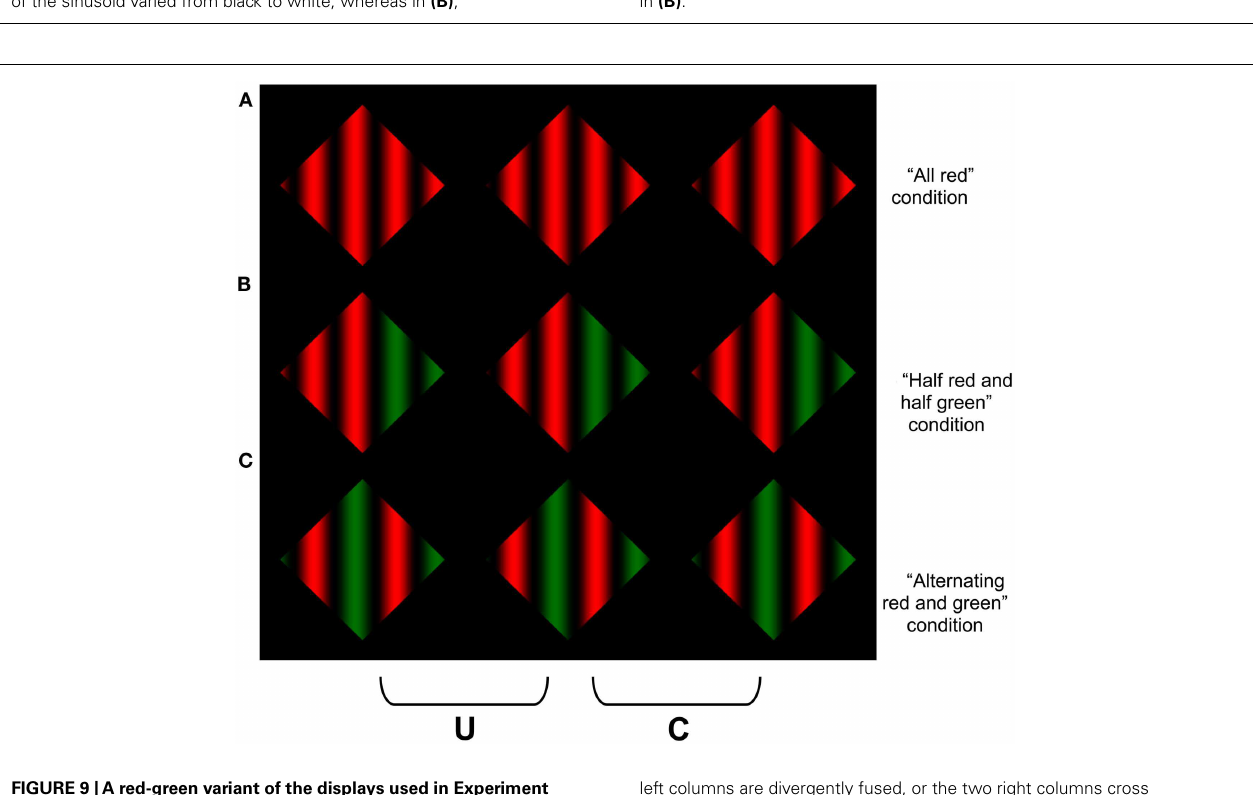
FIGURE 8 |An amplitude modulated achromatic version of the sinewave stimuli used in Experiment 1. In (A) , all of the cycles of the sinusoid varied from black to white, whereas in (B) ,